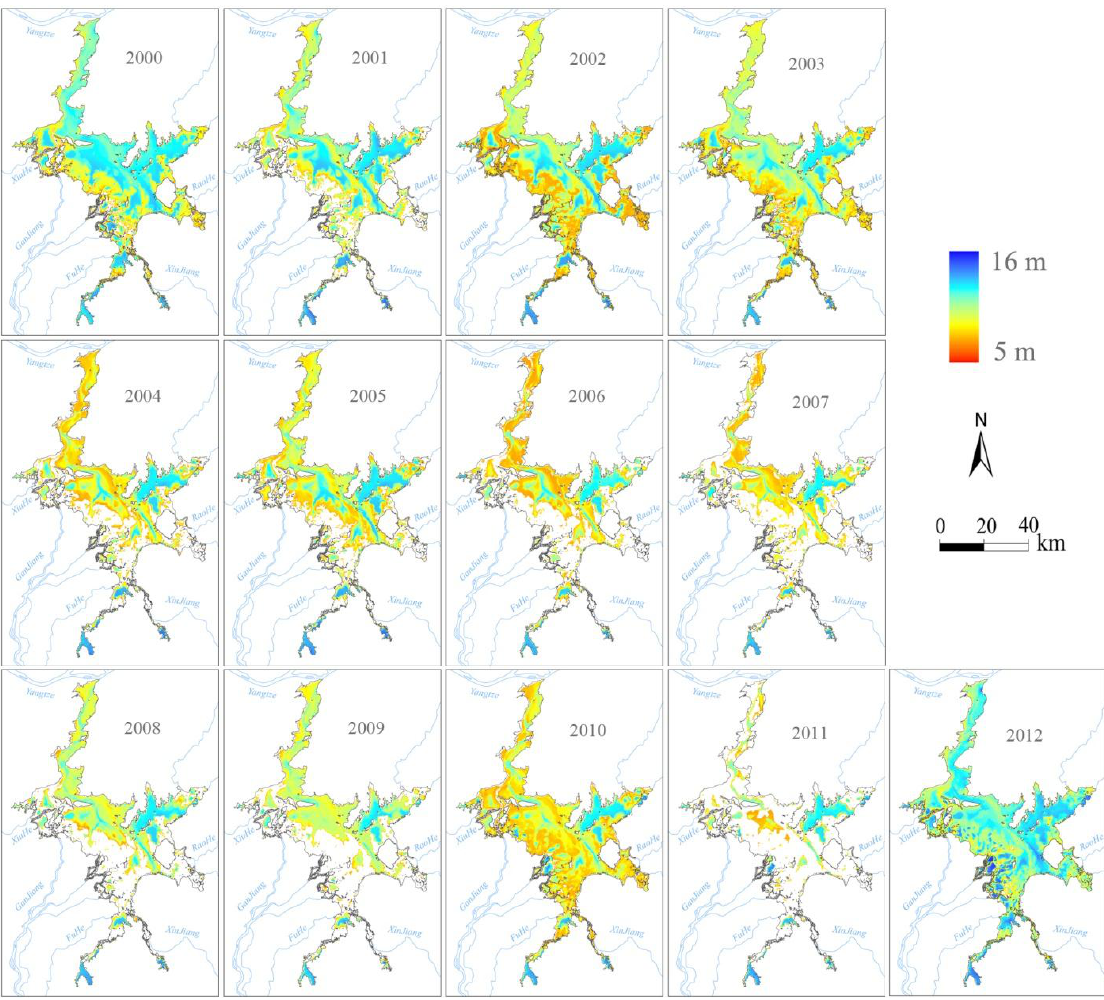
Figure 7. Inter-annual mean water level distribution of Poyang Lake from 2000–2012. The water level distribution map was generated with 10-month data because of availability of MODIS images in 2000. The cells with the inundation frequency of <50% in each calendar year were